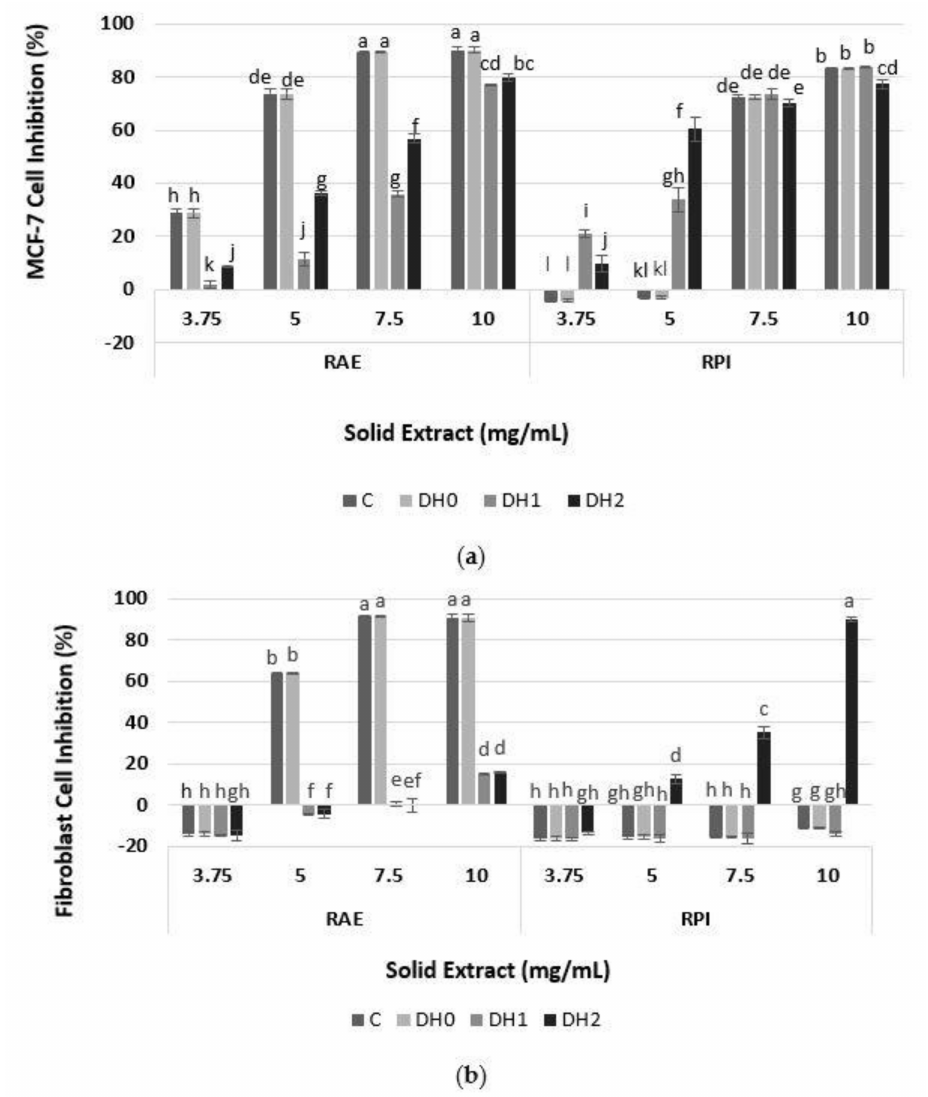
Figure 3. Cell inhibition of protein hydrolysates extracted from RAE and RPI ( a ) on MCF-7 cancer cell line, and ( b ) on healthy human fibroblast cell. Percentages of inhibition are calculated with reference to the signal of cells grown from extract-free cell culture media. C: control; DH0: without hydrolysis (time 0); DH1: hydrolysis 8.5–9.0%; DH2: hydrolysis 14.5–15.5%. Mean ± SD ( n = 3). The same letter means there is no significant difference ( p < 0.05), 95% confidence